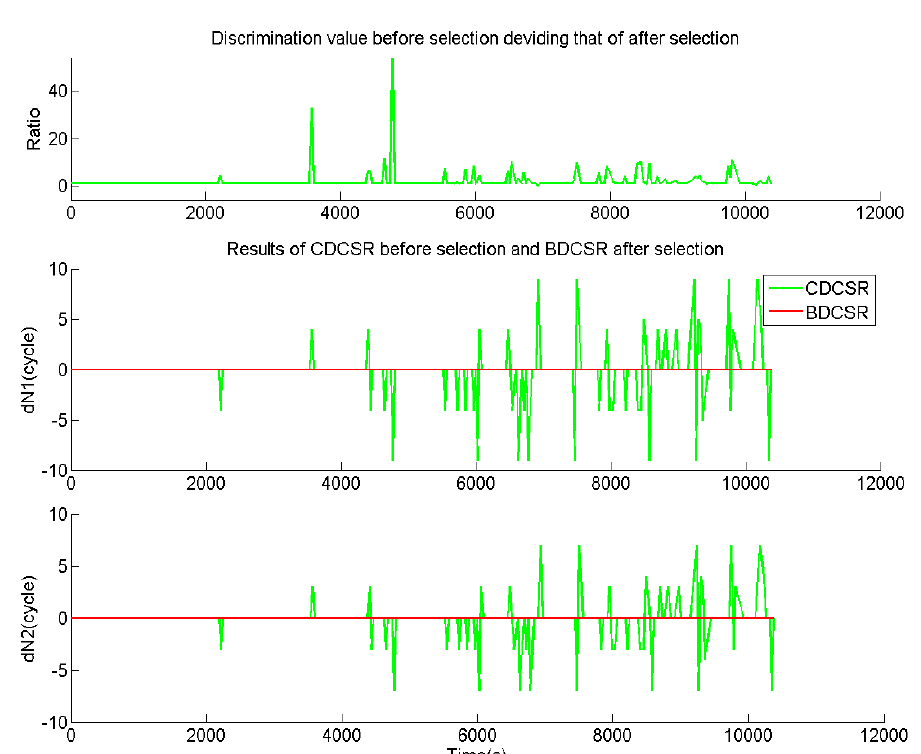
Figure 9. Results of CDCSR before selection and BDCSR after selection with the discrimination function from MEO Satellite 11 in a weak condition of low elevations during the geomagnetic storm, where the phase data without cycle slip was collected at the CUT0 station started from UTC 8 May 2016 00:00:00 with an interval of 30 s.